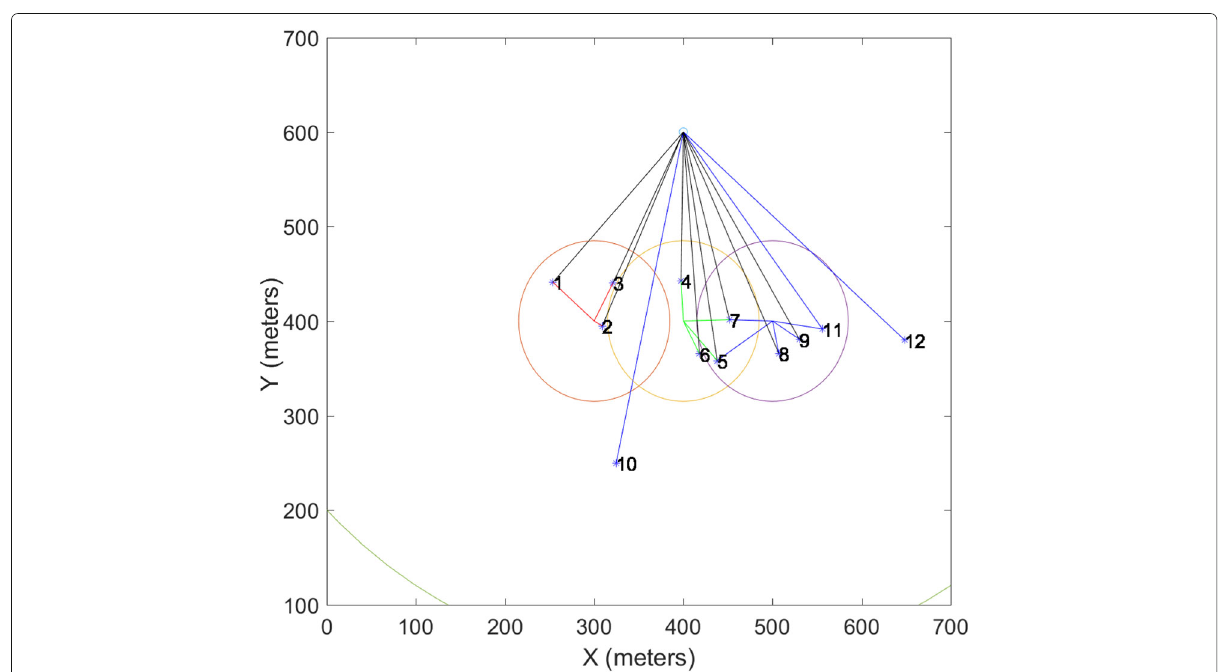
Fig. 2 Initial topology for the experiments